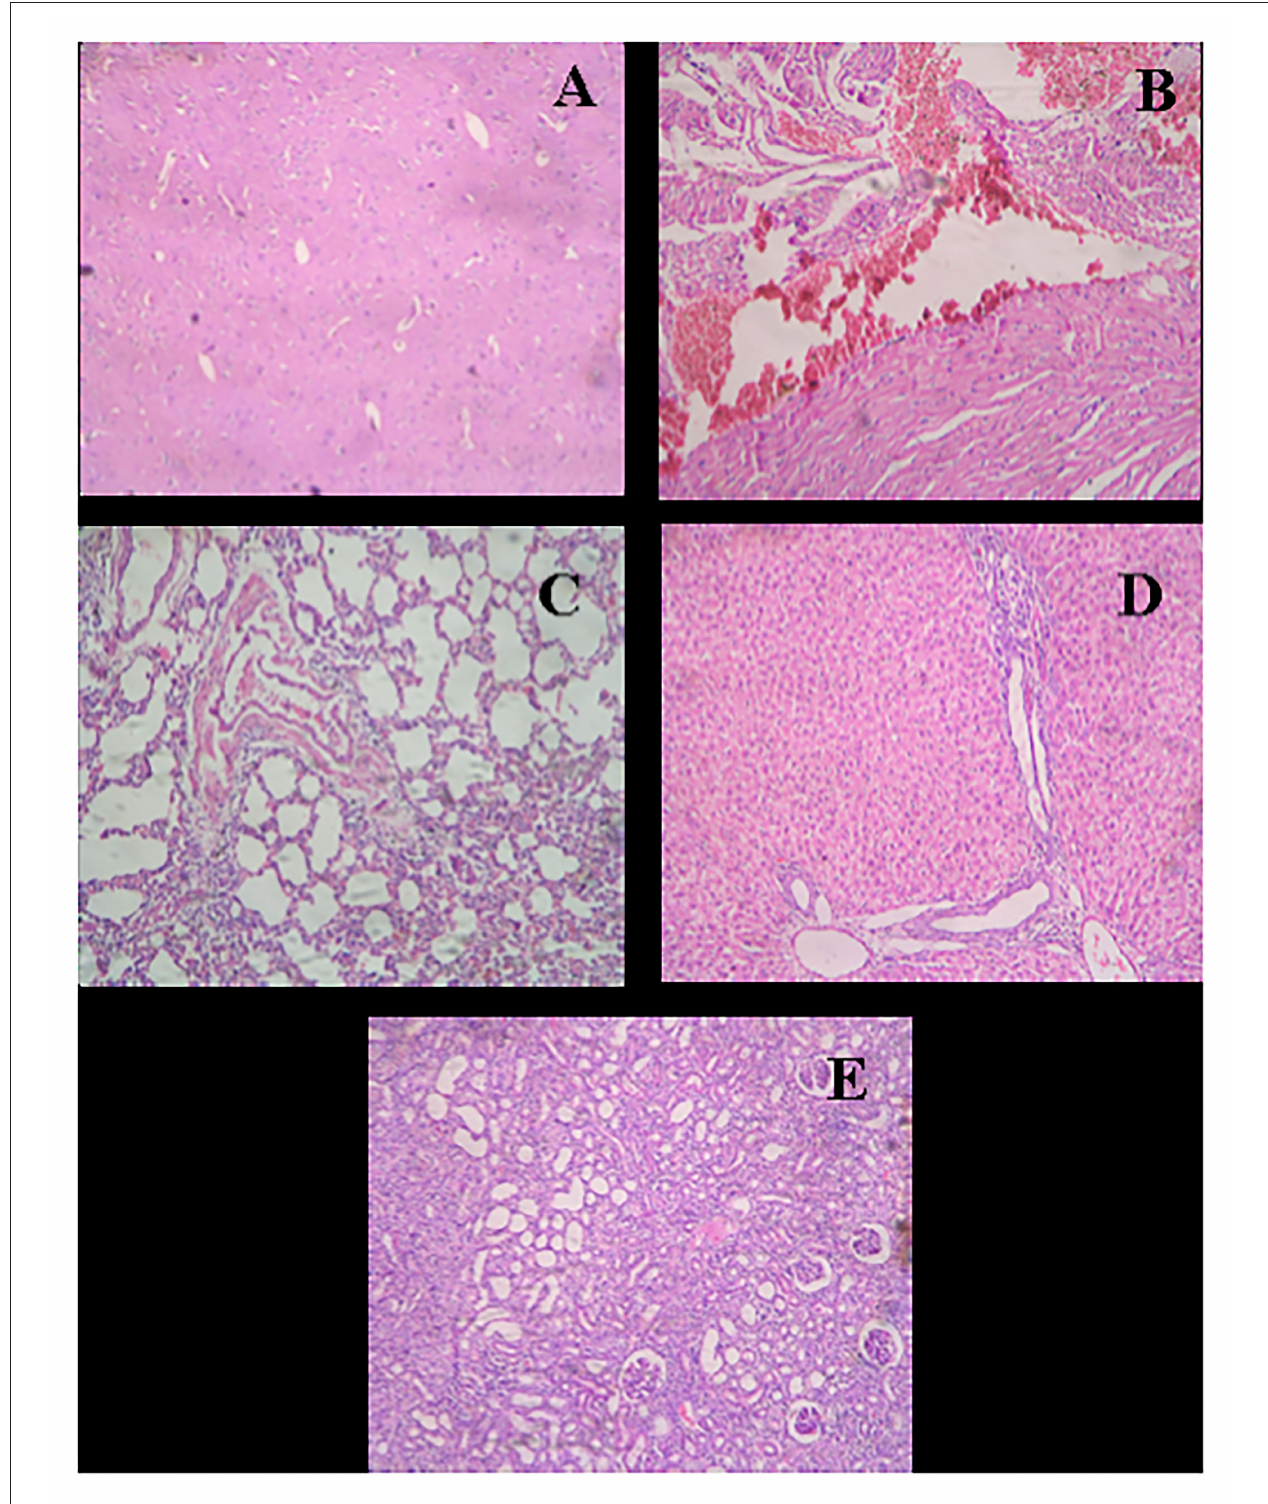
FIGURE 9 | Histological micrograph of organ’s tissue after wound-healing study of AgNPs at a concentration of 1mg g − 1 (Group C). (A) Section of brain tissue showing normal parenchyma; (B) Section of heart tissue showing myocardial hemorrhage; (C) Section of lung tissue showing bronchiolar round side infiltration and mild congestion; (D) Section of liver tissue showing granular and vacuolar changes; (E) Section of kidney tissue showing congestion, hemorrhage, and vacuolar changes (at a resolution of 40 × ).